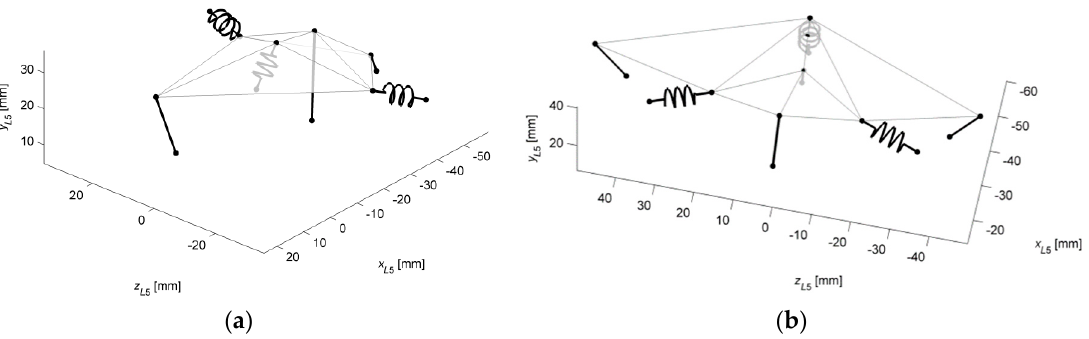
Figure 7. The substitute mechanisms for the IJ in a 3D view: ( a ) Case #2; ( b ) Case #3.